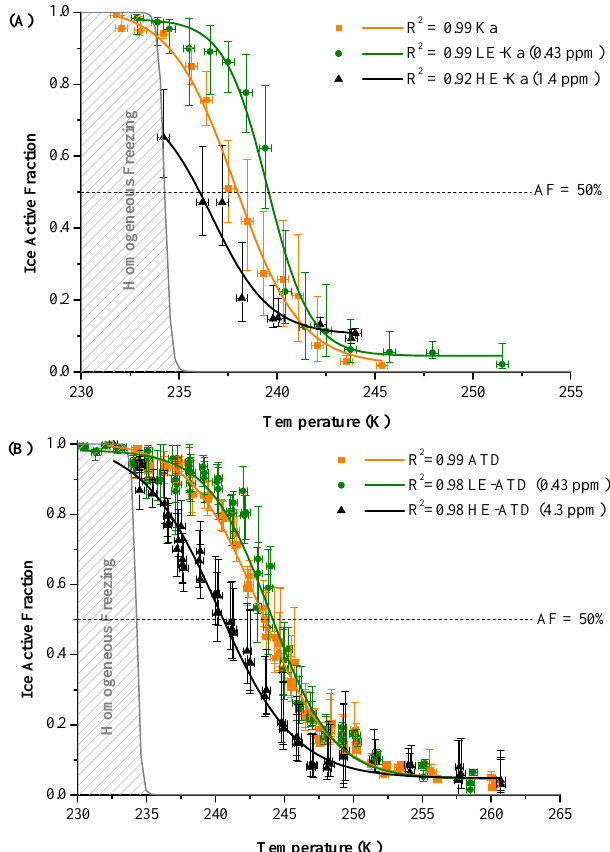
Fig. 8. Ice activated fraction as a function of temperature for im- mersion mode nucleation of (A) Ka and (B) ATD. Sigmoidal fit equations for curves are presented in Table 4. Homogeneous freez- ing parameterization is for 10µm water droplets (Earle et al., 2010). Dashed line indicates 50% of particles frozen. The temperature at which this line intersects the fit lines refers to T 50% (see text for more details).